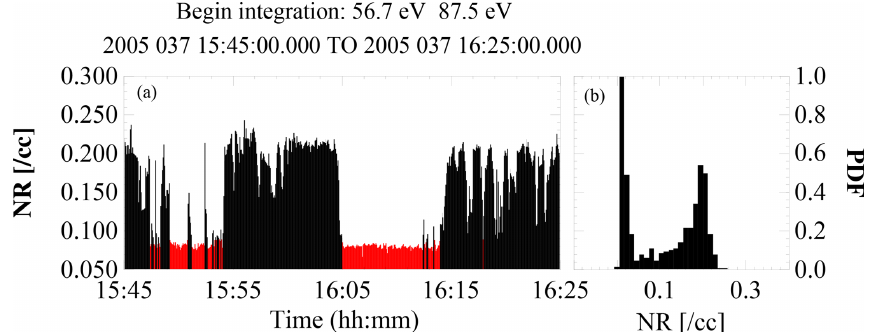
Figure 2. Figure demonstrates the bimodal aspect of the return electron density upstream of the bow shock. Panel (b) is a PDF computed for a 40min stretch when Cluster-2 was upstream of the shock. The two bimodal peaks are obvious. Panel (a) shows the time dependence of the same data. Red indicates when the spacecraft was in the solar wind, which was determined using a 0.09cm − 3 breakpoint in the return